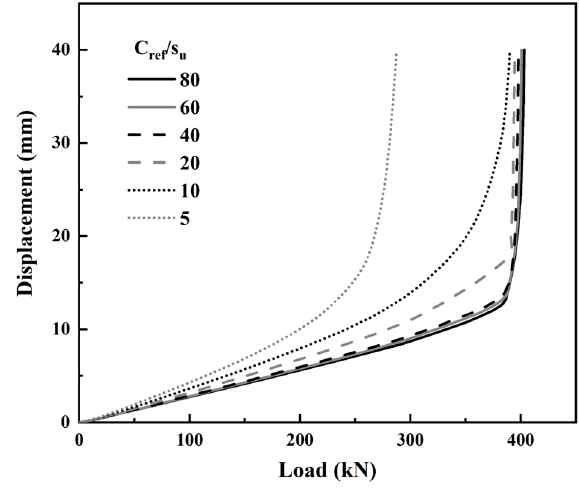
Figure 6. Load–displacement curve of HSCM-1-1 .